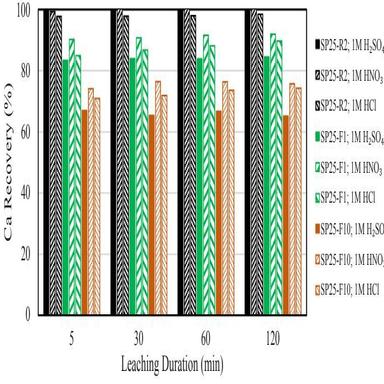
Leaching recoveries of calcium from the Guxu core samples.